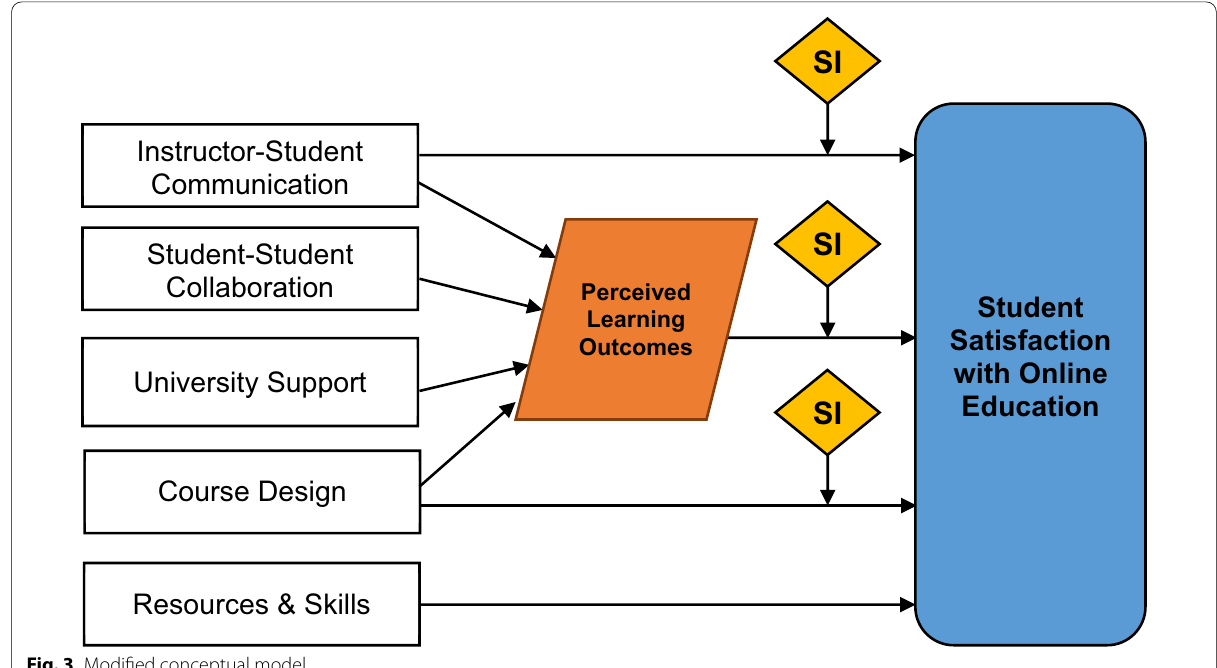
Fig. 3 Modified conceptual